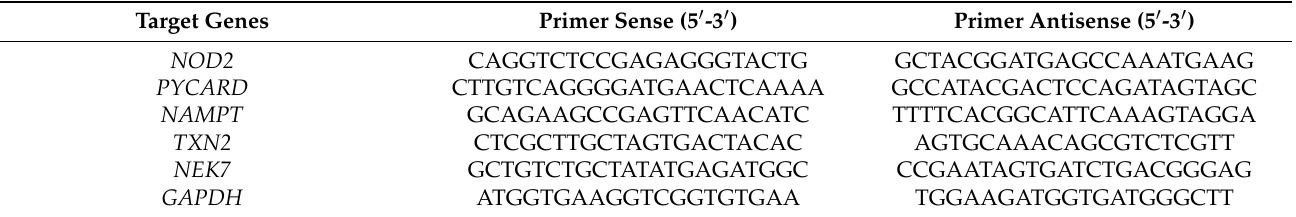
Table 1. Primer sequences used for